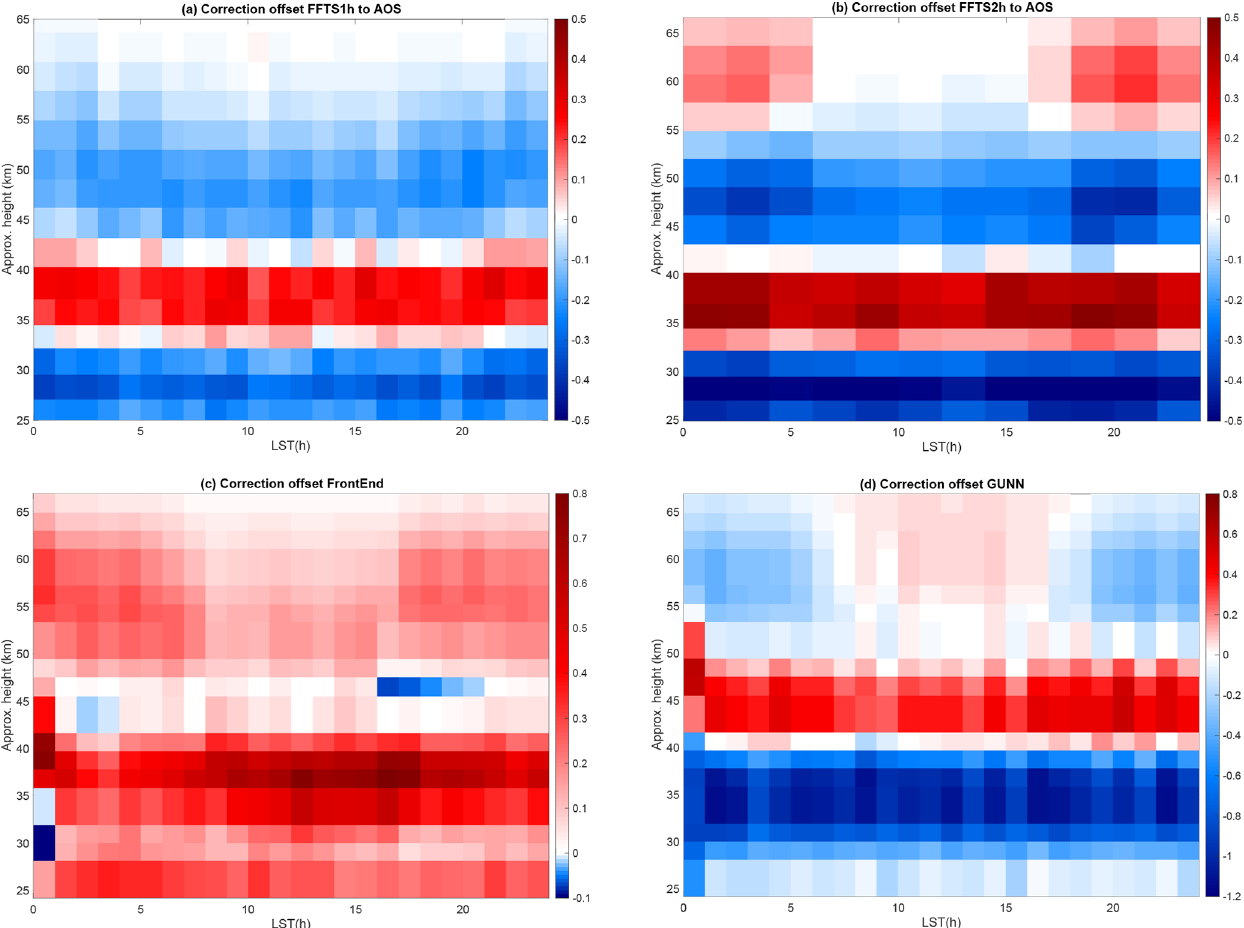
Figure 3. (a, b) Payerne MWR AOS setup vs. FFT setup offset profiles in parts per million as a function of LST; (c) correction offset for the front end (in 2005) and (d) for the GUNN oscillator (in 2009) technical upgrades.